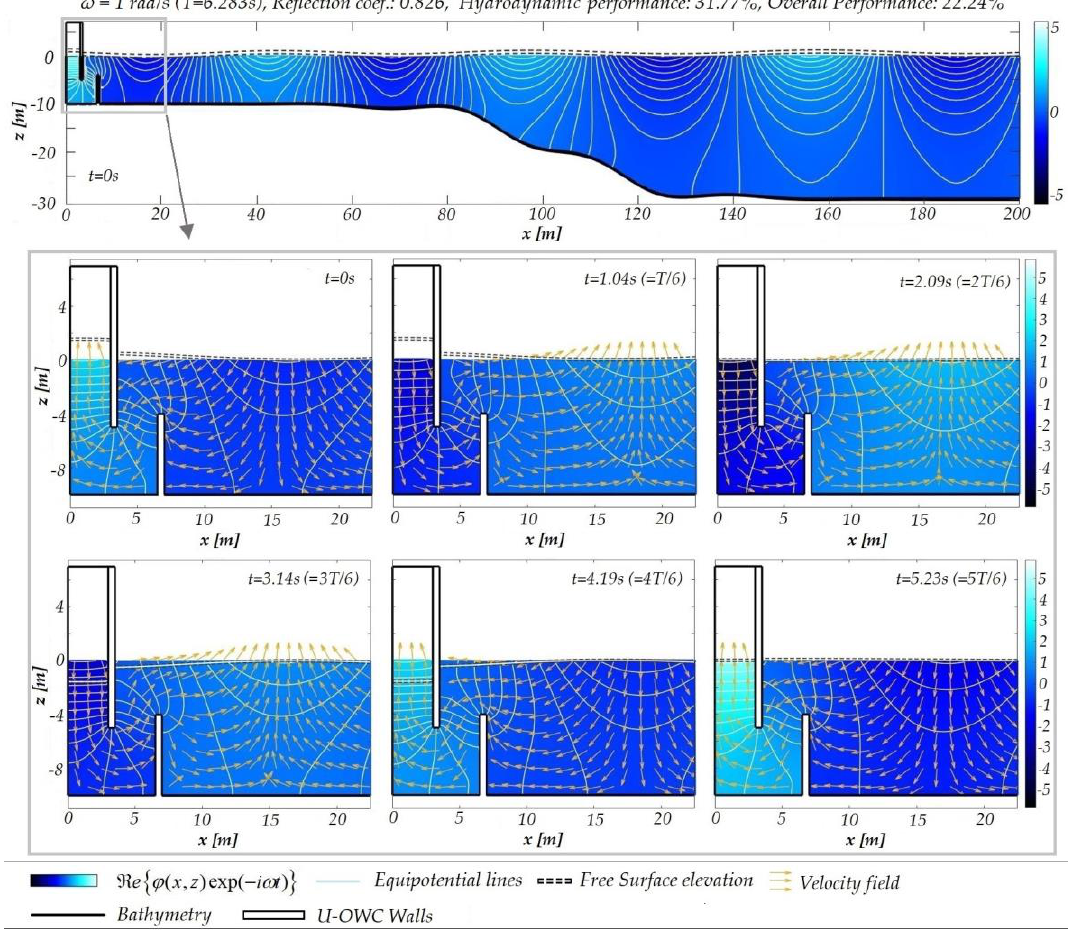
Figure 10. Wave potential and velocity fields at different time instants during a U-OWC’s operation in a variable bathymetry region ( Parameters : h a = 10 m , h b = 30 m , b = b w = 3 m , d = d w = 0.5 m , D = 5 m . h w = 7 m , (cid:101) λ = − 1.4, h c = 7 m , κ = 0.05, δ h c ( x ) = 2sin [ 0.2 ( x − x m )] exp [ 10 − 3 ( x − x m ) 2 ])